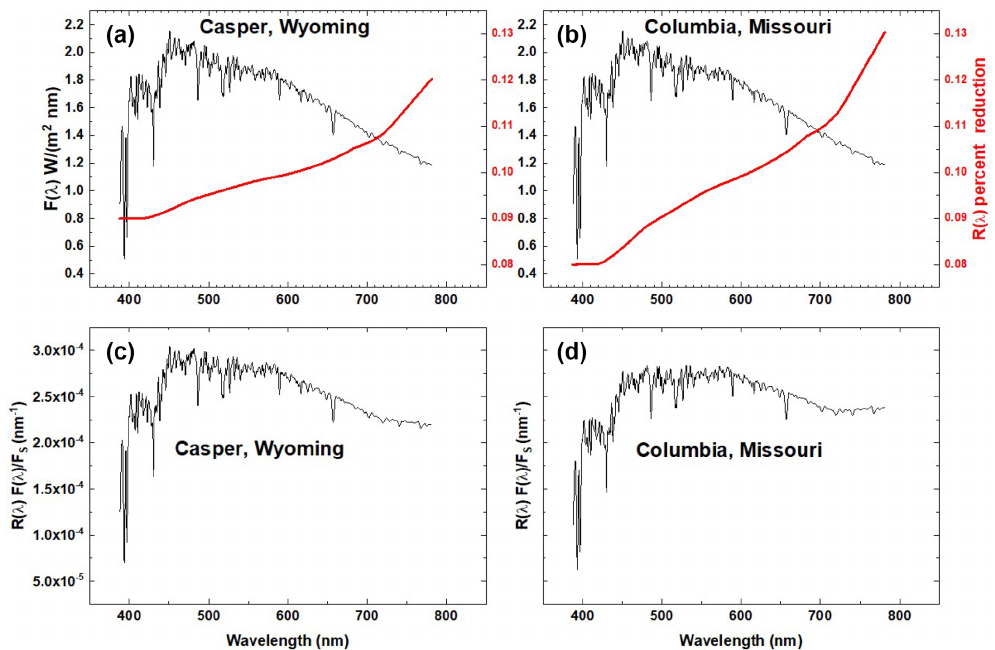
Figure 10. Solar irradiance at 1AU F(λ) Wm − 2 nm − 1 (Mayer and Kylling, 2005) and the eclipse reduction function R(λ) in percent for Casper, Wyoming (red curve in panel a ), and Columbia, Missouri (red curve in panel b ). Fractional reduction (nm − 1 ) in reflected solar irradiance in the direction of L 1 for Casper, Wyoming (panel c ), and Columbia, Missouri (panel d ).